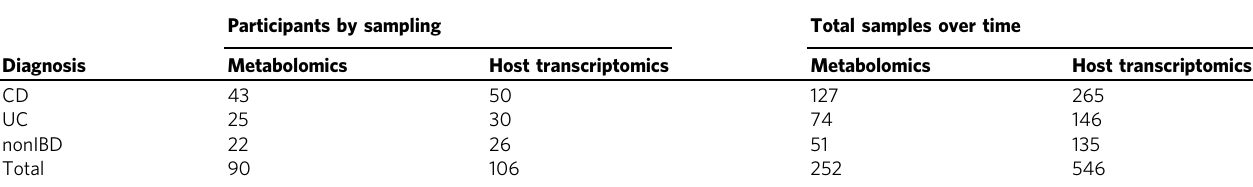
Table 1 Overview of the samples and patient dataset used in this study (after fi ltering from the original study by Lloyd-price et al 9